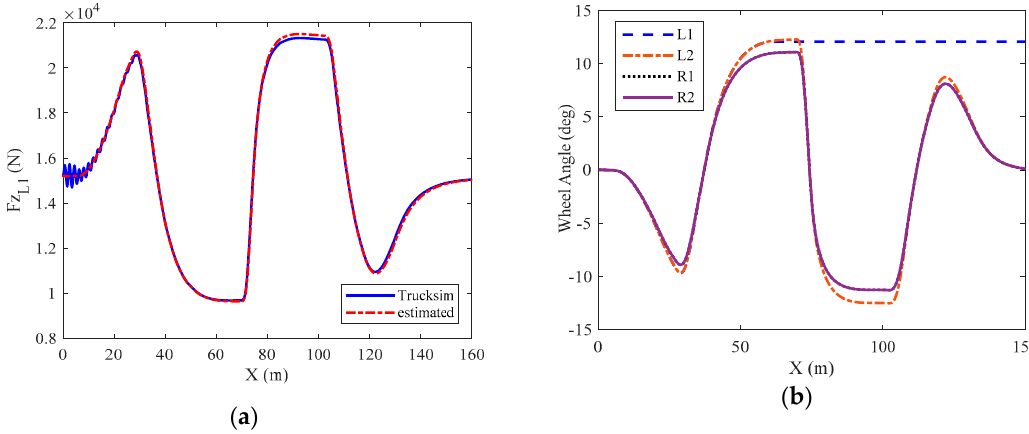
Figure 5. Vehicle driving parameters changes. ( a ) Vertical tire force of the failed wheel; ( b ) wheel angle.